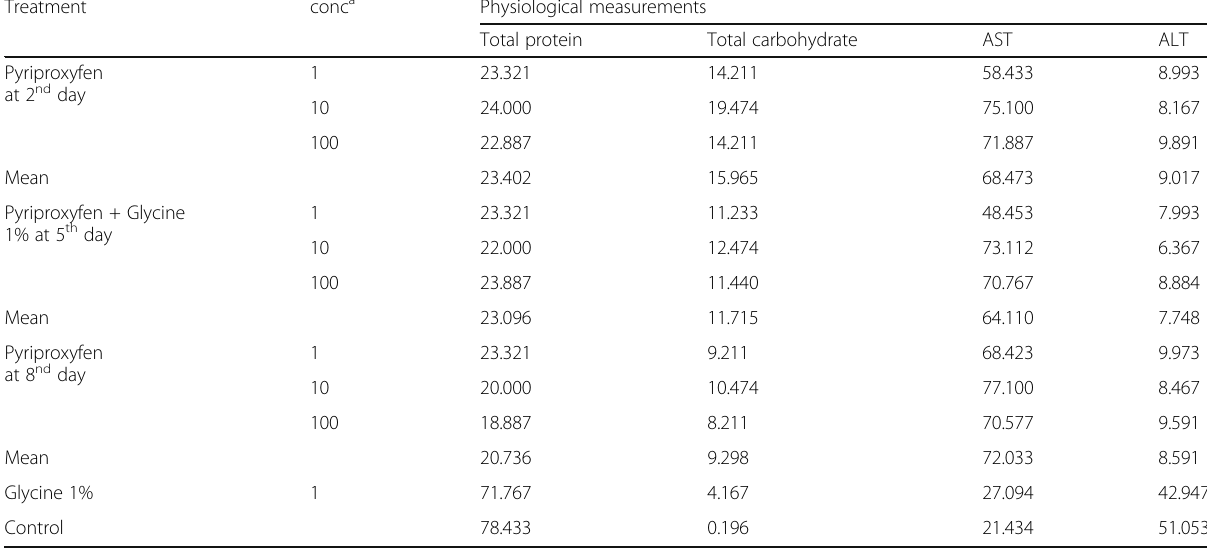
Table 3 Effect of pyriproxyfen and glycine on physiological measurements Treatment conc a Physiological measurements Total